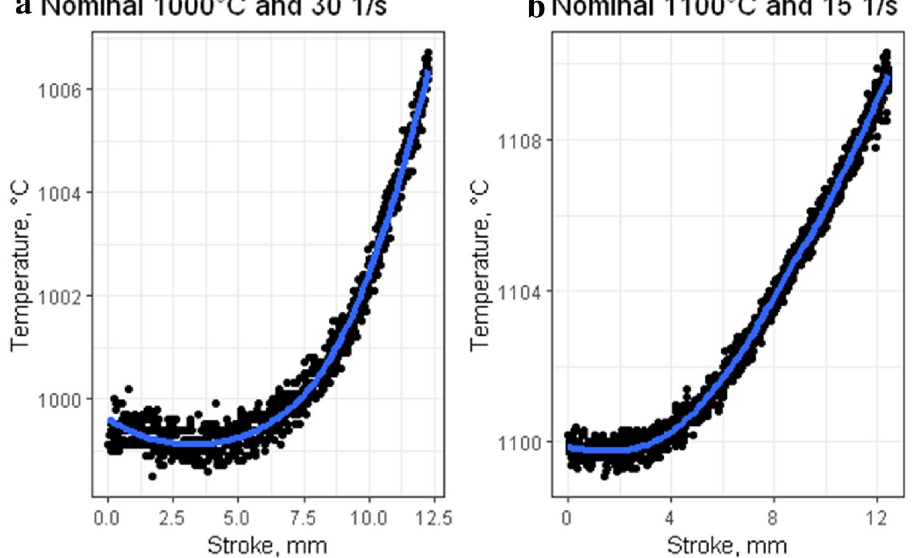
Fig. 3 Example of temperature measured during the experi- ments for a 30 1/s at 1000 °C and b 15 1/s at 1100